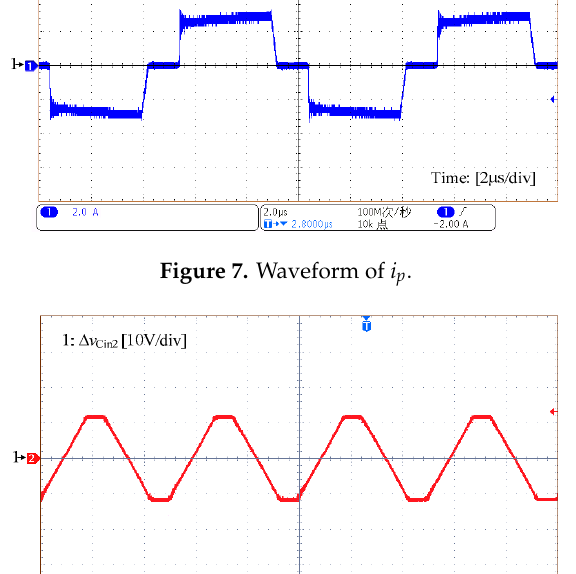
Figure 8. Waveform of Δ v Cin2 .